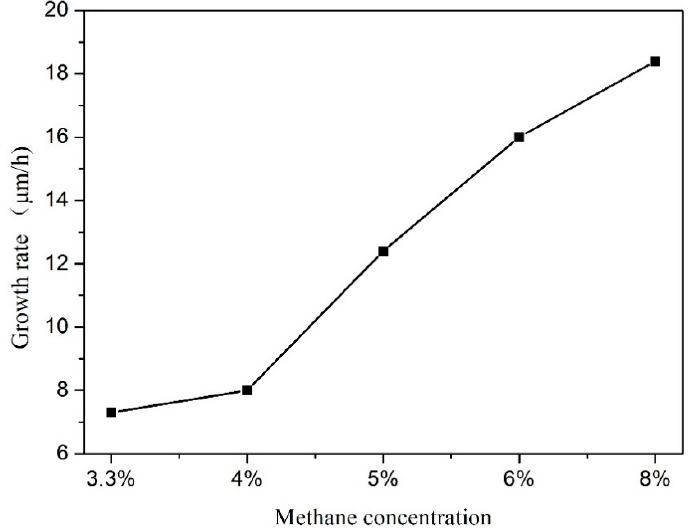
Figure 5. Growth rates of the deposited diamond films, with the methane concentration varying from 3.3% to 8%.